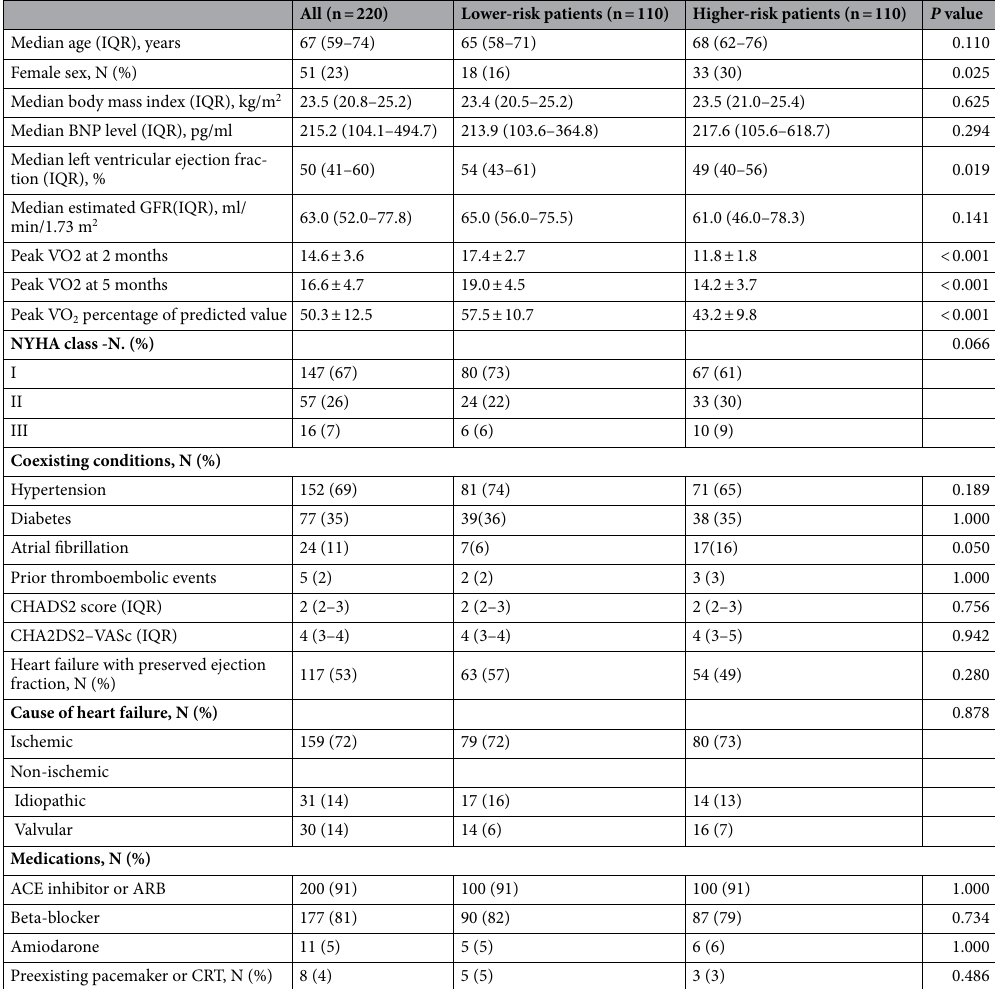
Table 1. Clinical characteristics of the enrolled patients. IQR; interquartile range, GFR; glomerular filtration rate, NYHA; New York Heart Association, ACE; angiotensin-converting enzyme, ARB; angiotensin II receptor blocker, CRT; cardiac resynchronization therapy, BNP; brain natriuretic peptide, GFR; glomerular filtration